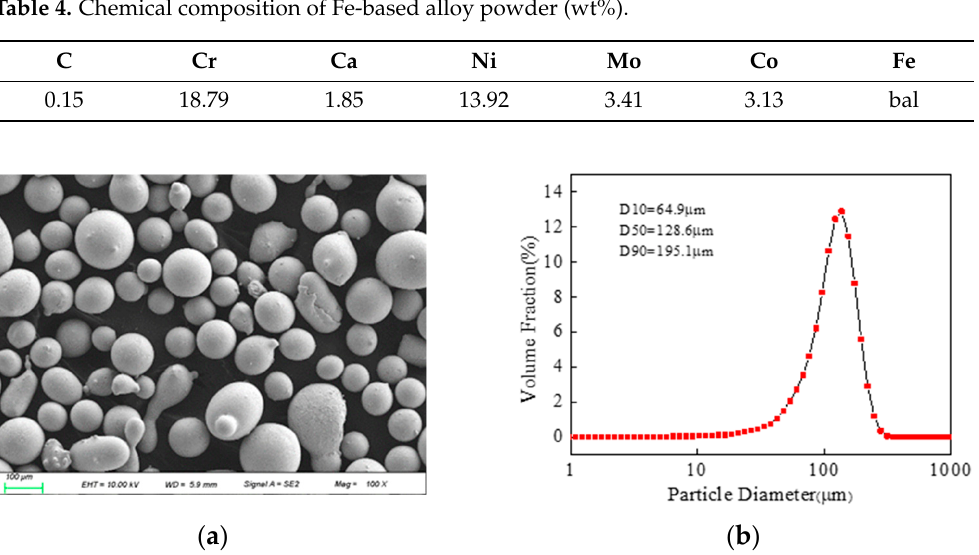
Table 4. Chemical composition of Fe − based alloy powder (wt%).